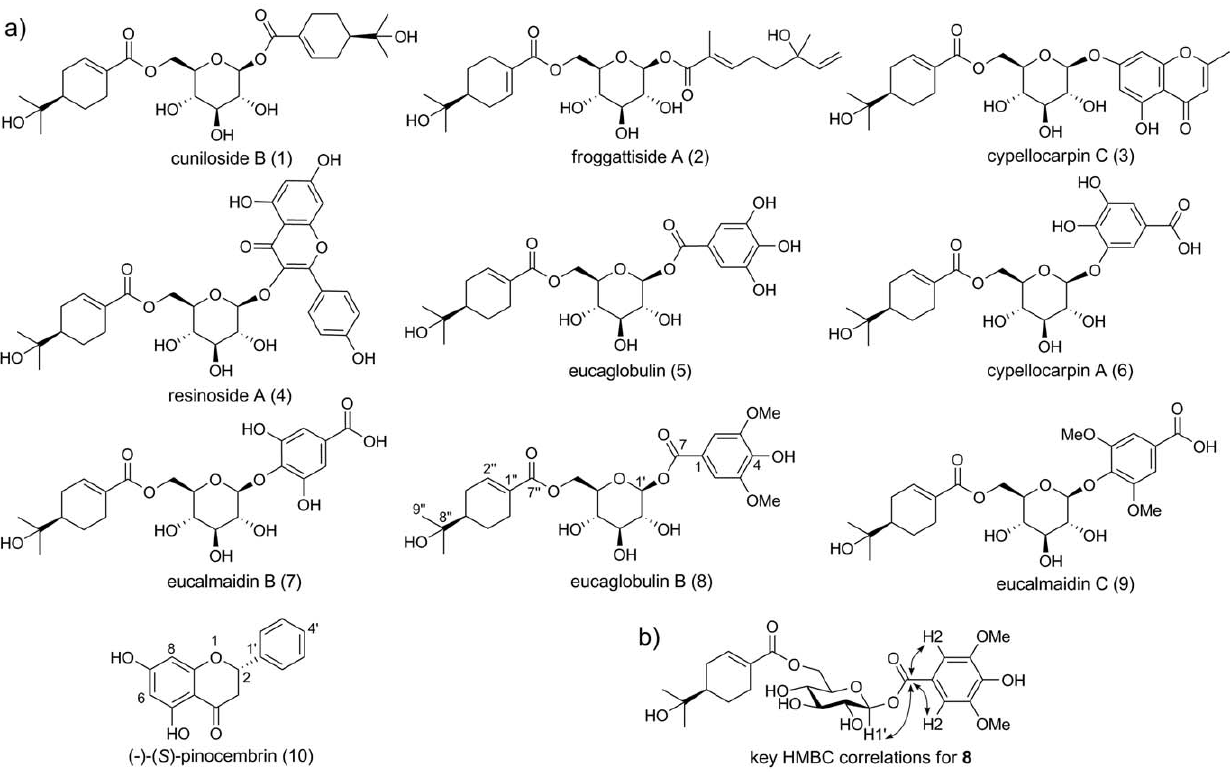
Figure 1. Structures of non-volatile compounds localized to the foliar secretory cavities of Eucalyptus species and Melaleuca armillaris. (a) Oleuropeyl glucose esters and the flavanone, pinocembrin ( 10 ) and (b), key HMBC correlations used in the structural elucidation of eucaglobulin B ( 8 ).